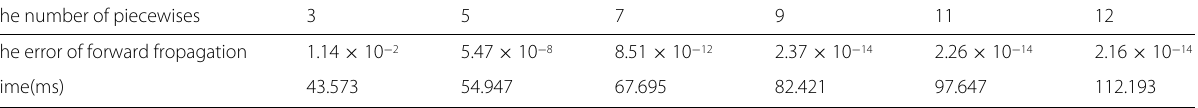
Table 3 Comparison of error and time according to different tanh piecewise-linear functions The number of